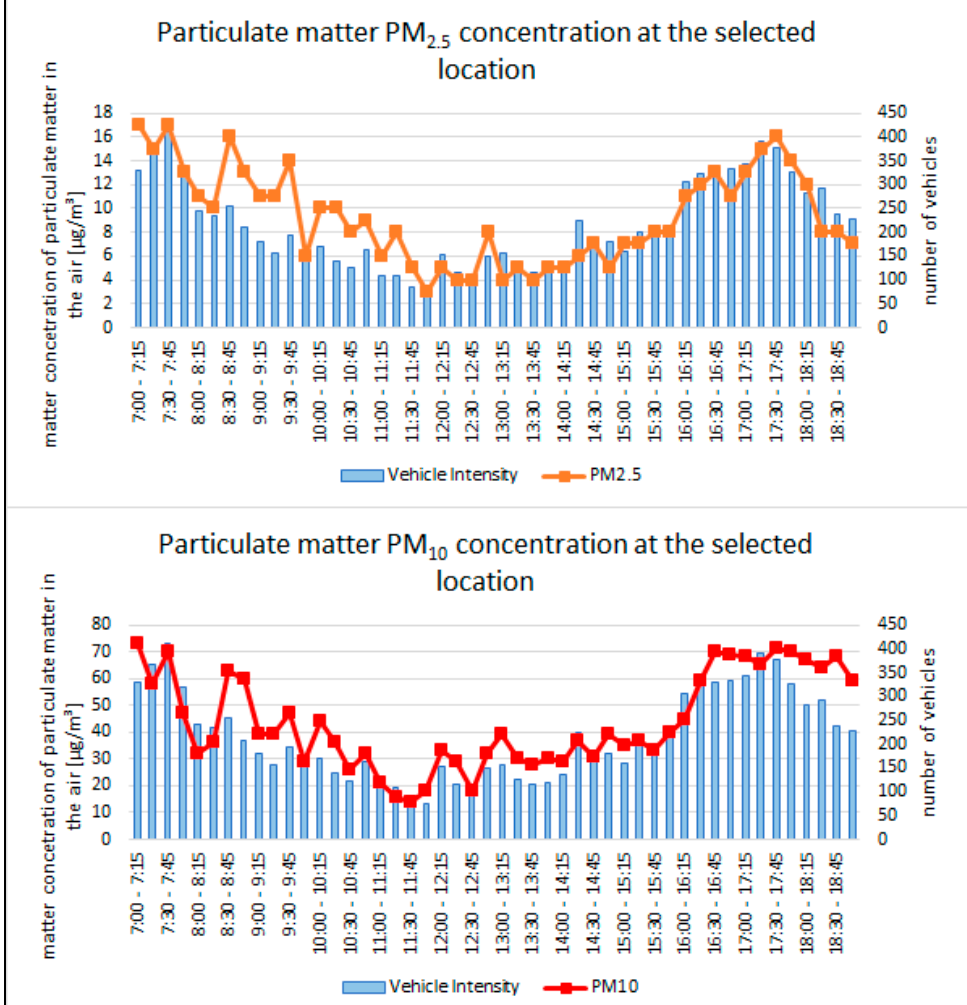
Figure 5. Particulate matter concentration at selected location—railway crossing.